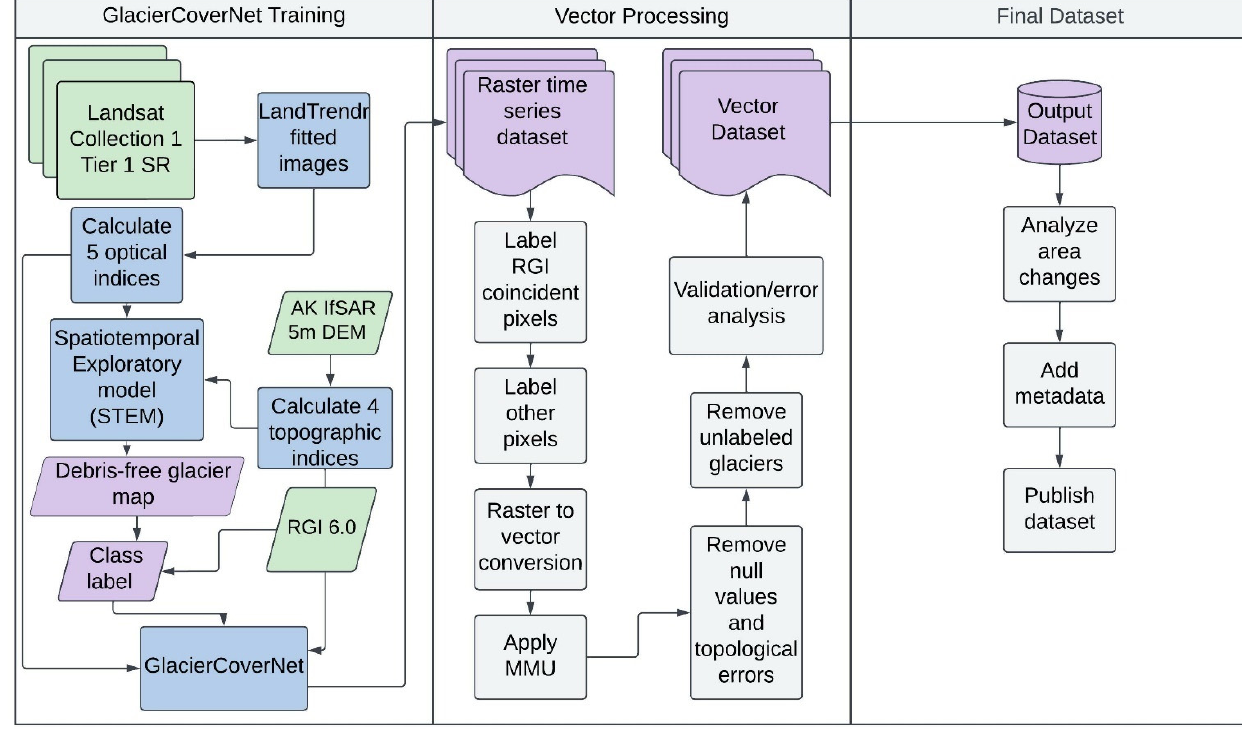
Figure 2. Conceptual workflow showing data inputs in green, algorithms in blue, computational outputs in purple, and post hoc processing steps in gray.